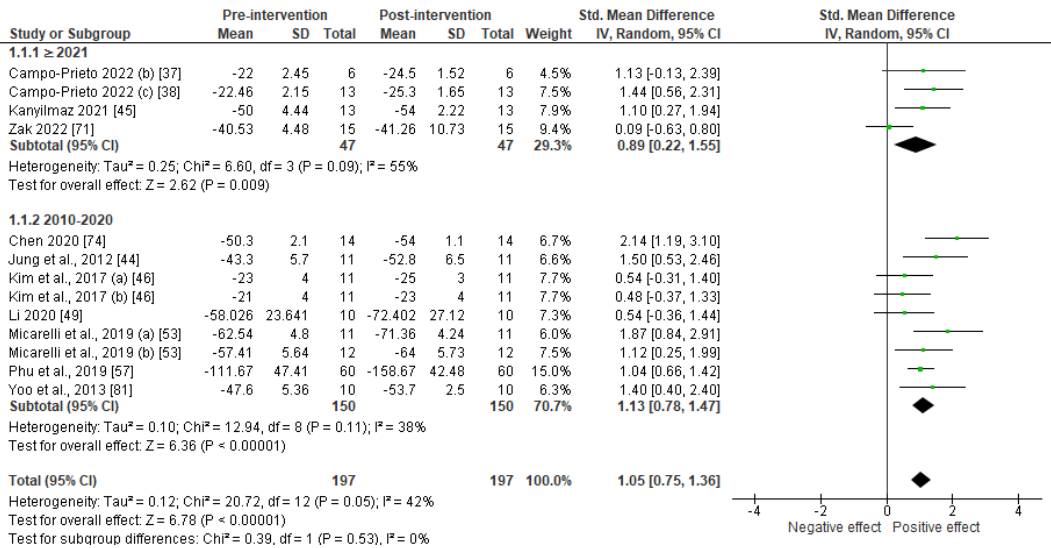
Figure 2. Forest plot of effects of intervention using immersive technologies on balance.